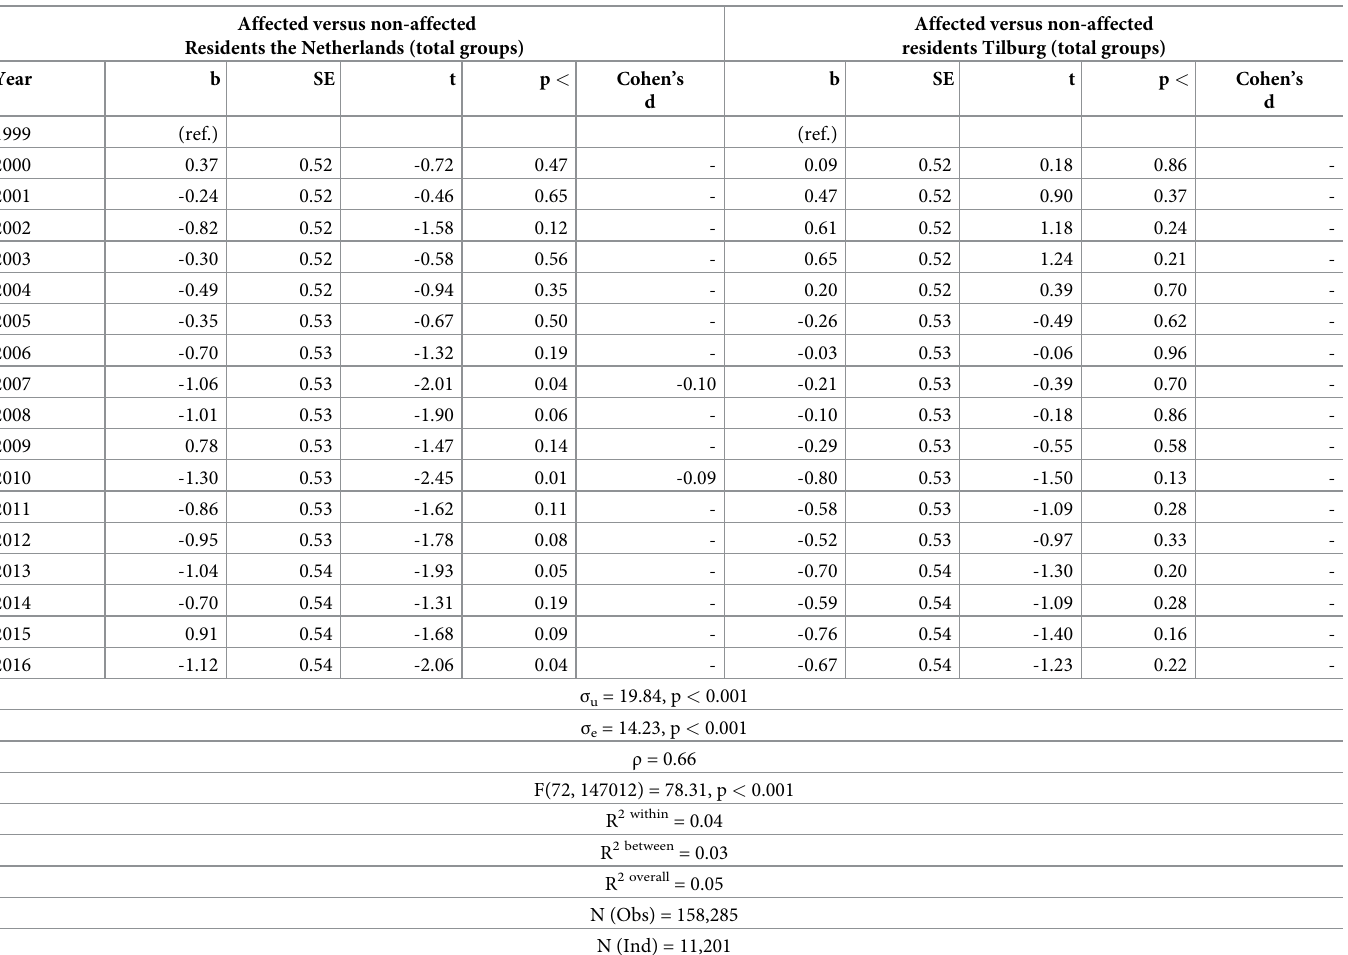
Table 4. Results of fixed-effects linear panel regression models for total groups with employment security as dependent variable (1999–2016). Affected versus non-affected Residents the Netherlands (total